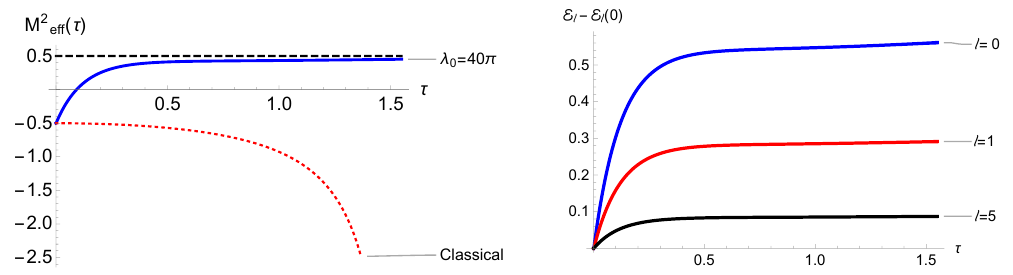
Figure 5 . Left : the e(cid:11)ective mass squared starts o(cid:11) at a negative value (= (cid:0) 0 : 5) at (cid:28) = 0, but rapidly saturates to a positive value (cid:25) 0 : 5 at large values of the coupling (cid:21) 0 = 40 (cid:25) . Right : for the same initial conditions are shown the evolution of energy per mode for three di(cid:11)erent ‘ harmonics.